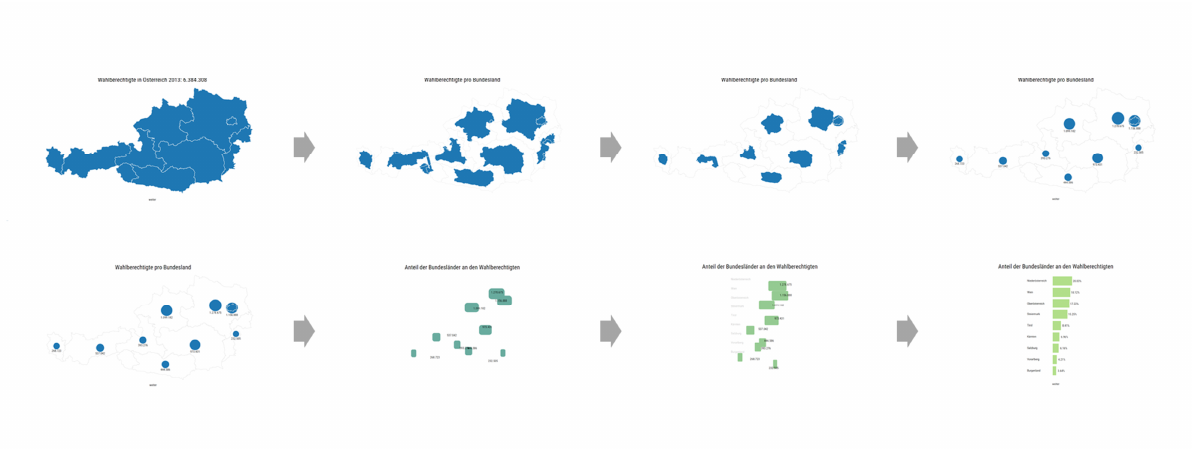
Figure 4: Smooth transitions leading from a well-known map of a territory (top left) to and abstracted cartogram showing number of eligible voters per federal state (top right) , to be transformed into a bar chart showing the voter participation of each state in the elections of Austria of 2012 (Flooh Perlot, 2016,